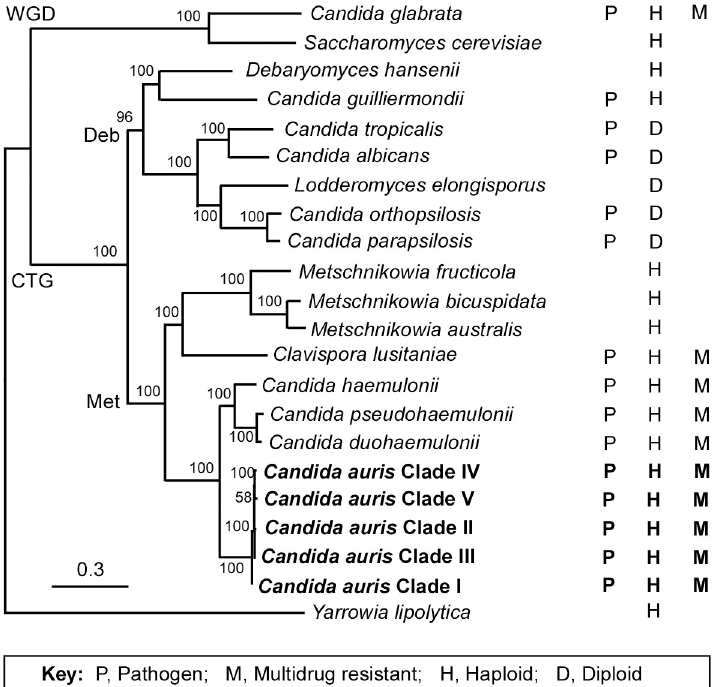
Fig 3. Maximum-likelihood phylogeny of the CTG and WGD clade species. The phylogenic tree was generated using the program RAxML v7.3.2 using 50 protein sequences aligned with Mafft-homologs. The GTR model, gamma distribution, and 1,000 bootstraps were used to construct the phylogenetic relationships. Pathogenic characteristics (P), ploidy (H or D), and multidrug resistance (M) for each species are also shown. CTG, the CTG clade; Deb, Debaryomycetaceae; GTR, generalized time reversible; Met, Metschnikowiaceae; WGD, the Whole Genomic Duplication clade.